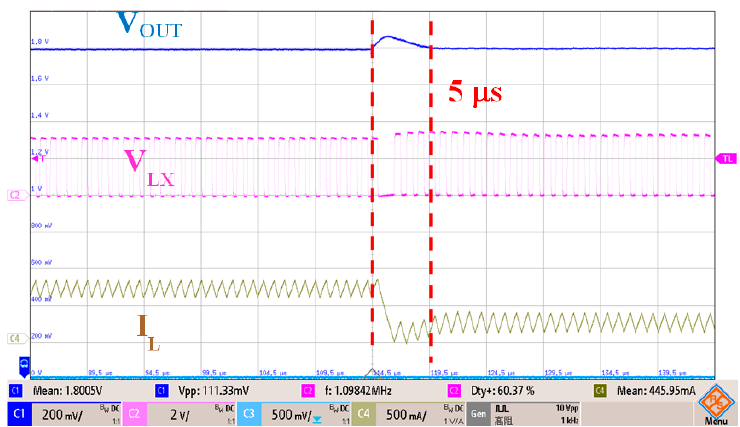
Figure 16. Measured transient recovery time with the proposed DC-DC buck converter for a step-down load from 200 mA to 700 mA.